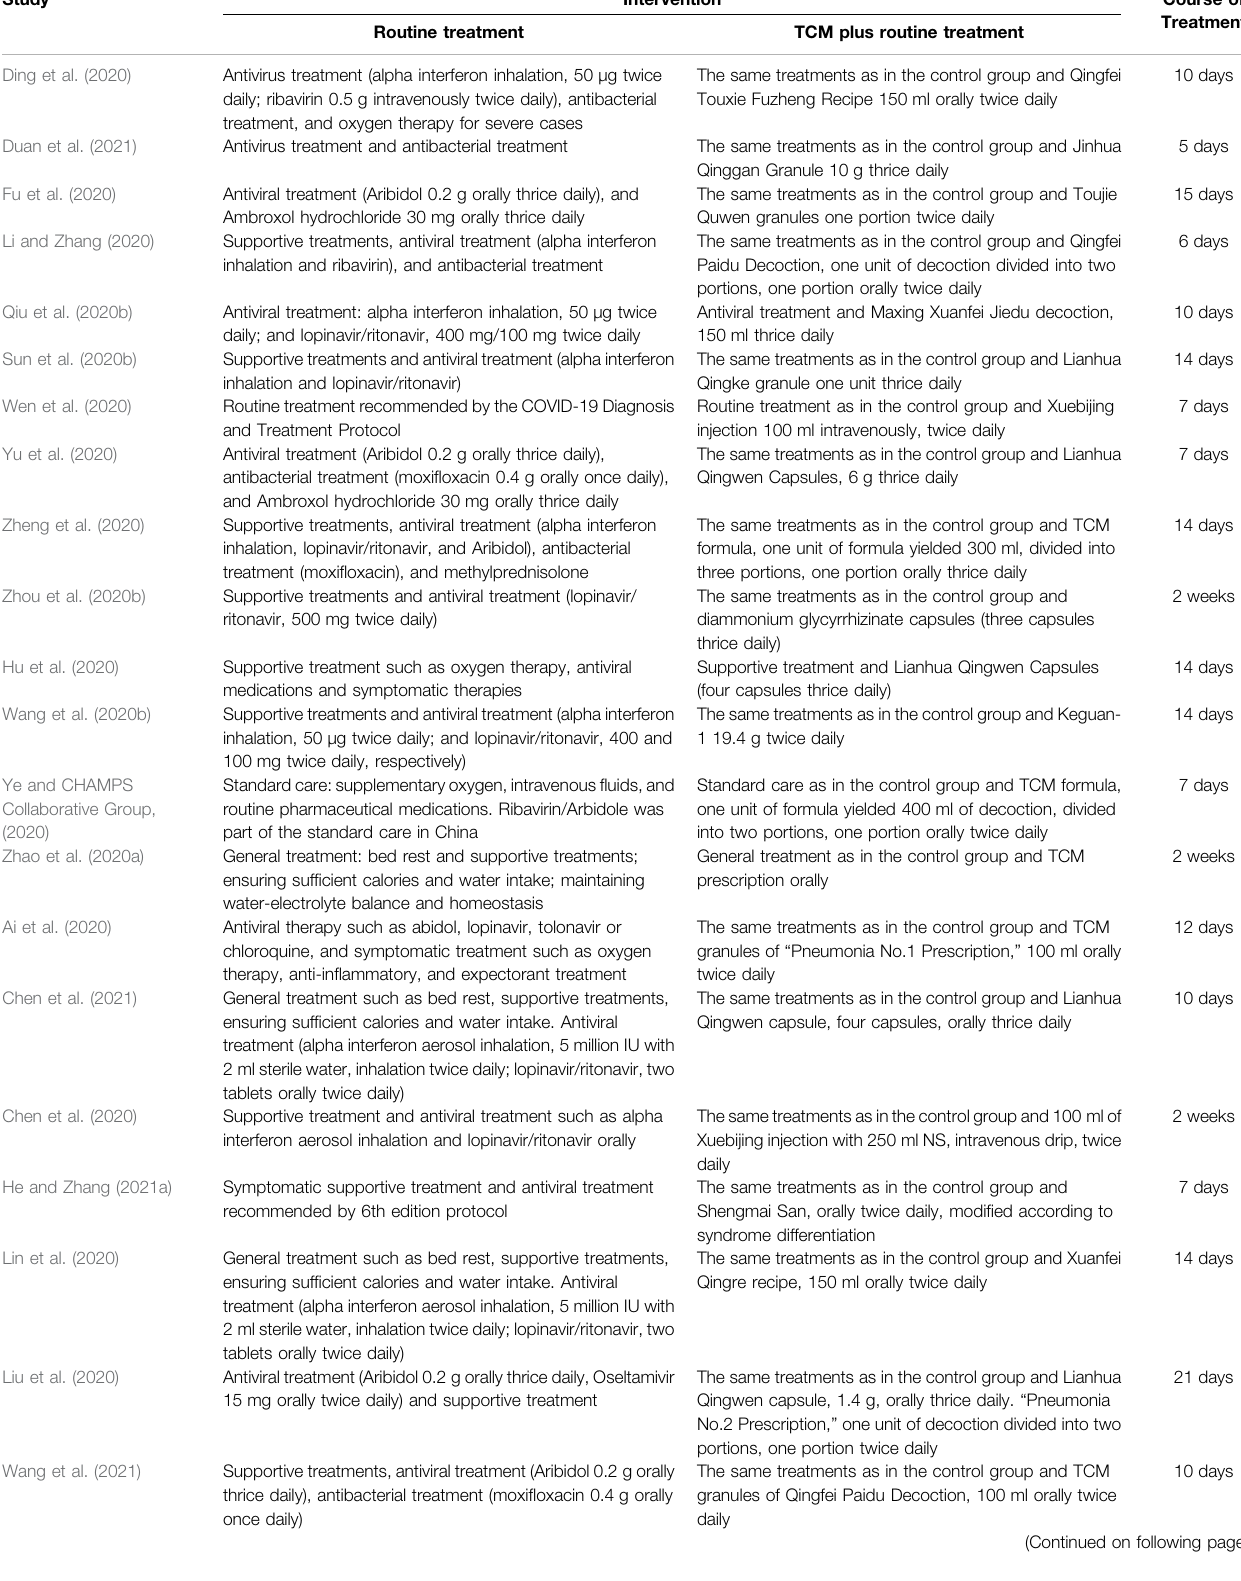
TABLE 2 | Intervention details of selected